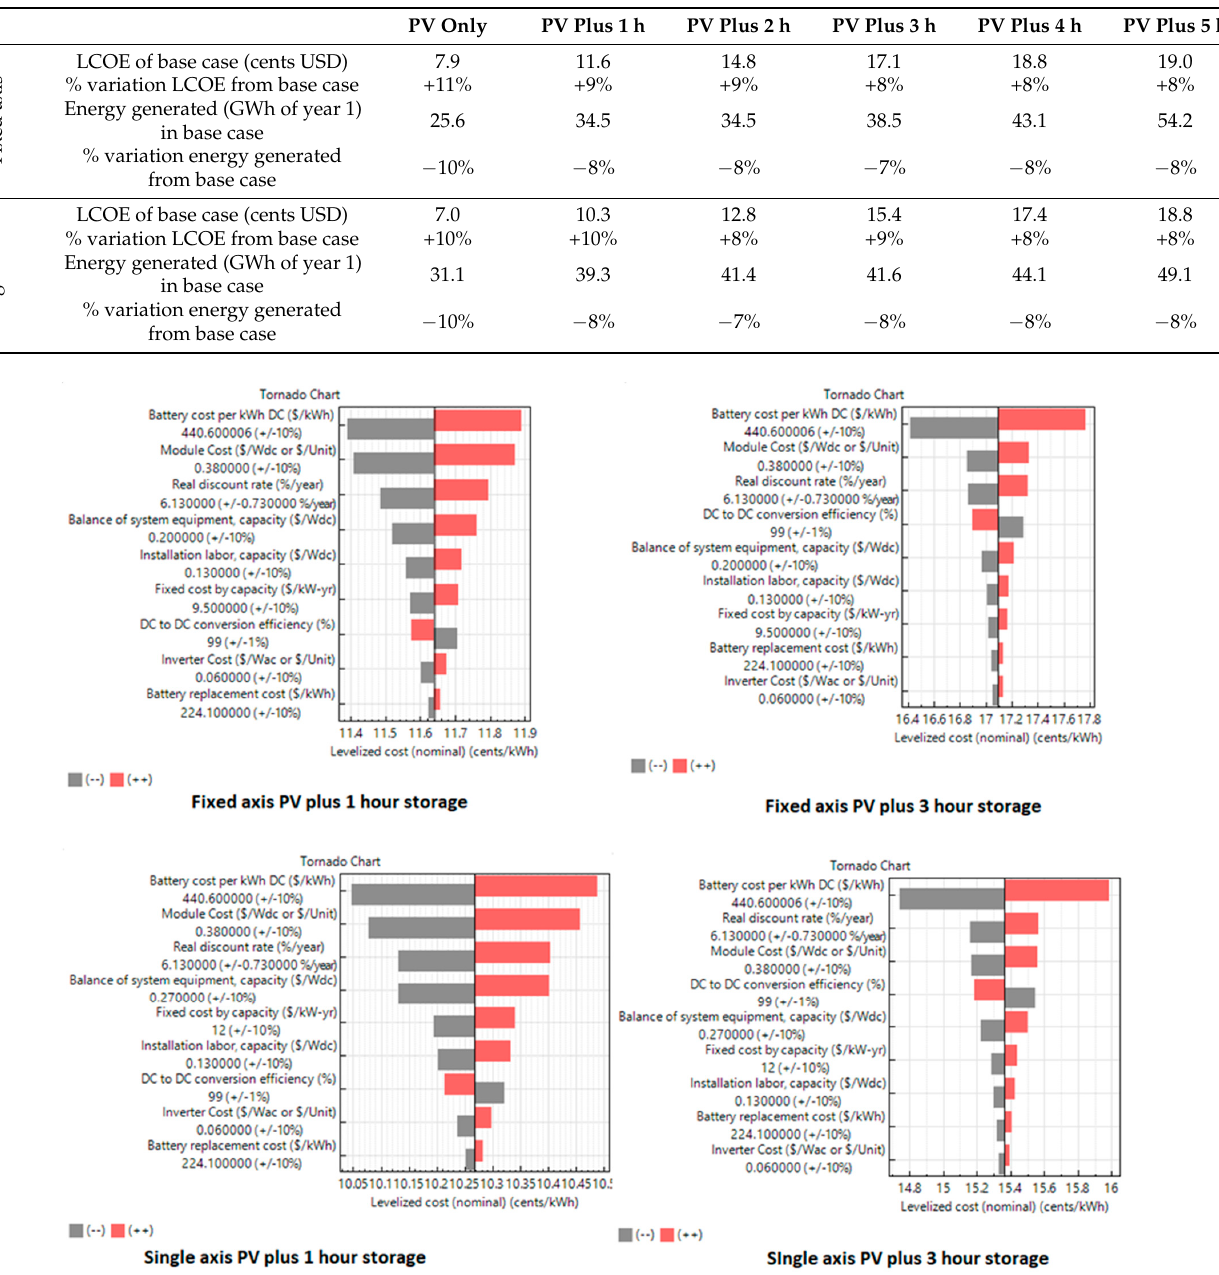
Table 10. Impact of 10% decrease in GHI on LCOE and generation.